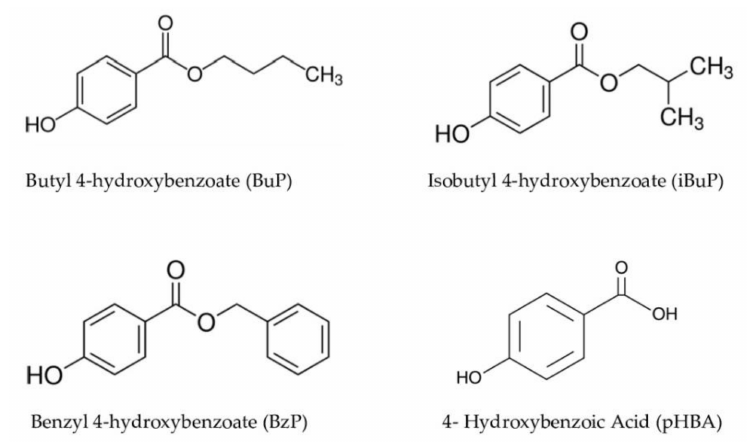
Figure 1. Chemical structure of parabens under investigation.